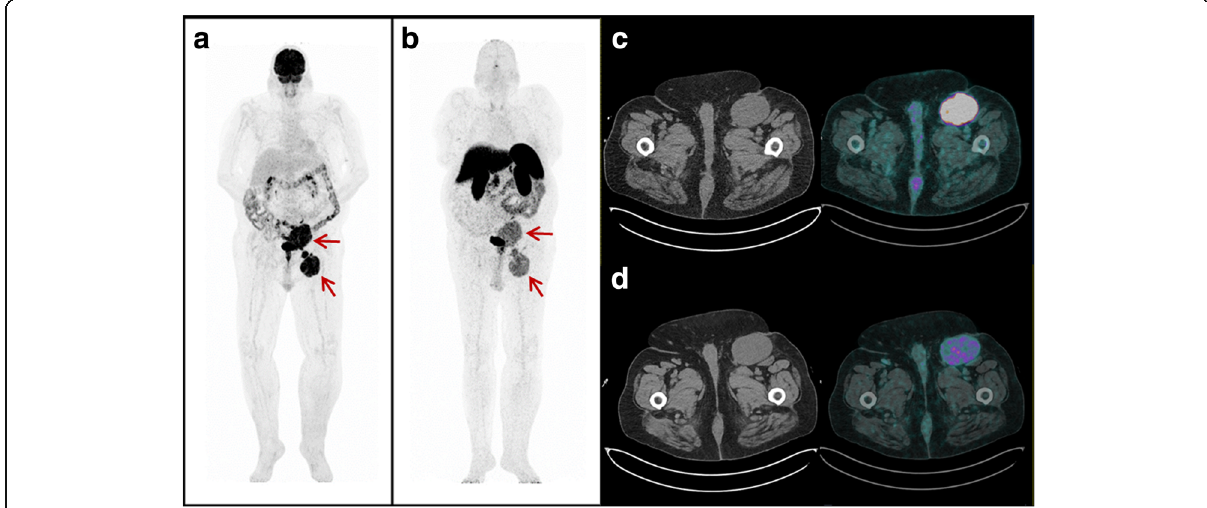
Fig. 1 PET/CT images performed after chemotherapy in patient #8, who presented with UPMCC diagnosed by left inguinal lymph node biopsy. Maximum intensity projection (MIP) 18 F-FDG PET/CT ( a ) and 68 Ga-somatostatin analog ( b ) PET/CT images concordantly showed abnormal tracer uptake in multiple left iliac and inguinal lymph nodes (red arrows). Transaxial 18 F-FDG ( c ), and 68 Ga-somatostatin analog ( d ) PET/CT images concordantly showed abnormal tracer uptake (higher with 18 F-FDG) in enlarged pathological left inguinal lymph